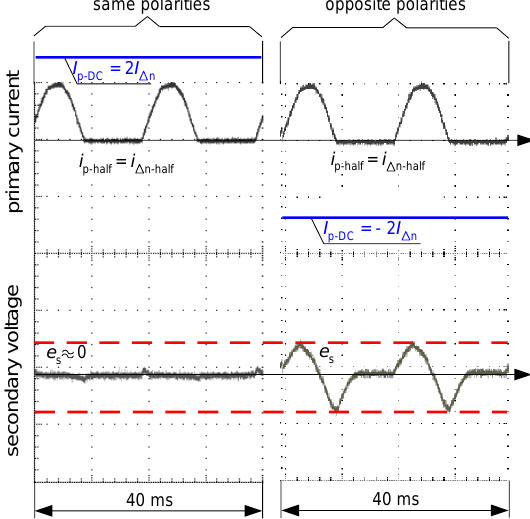
Figure 20. Oscillograms of the induced secondary voltage e s in case of the iron core of flat hysteresis loop (as in Figure 15b). Primary current i p composed of pulsating DC (half-wave) waveform ( i p-half = i ∆ n-half ) and DC component ( I p-DC ) of the value: I p-DC = 2 I ∆ n . Case 1 ( left ) — same polarities of the components; Case 2 ( right ) — opposite polarities of the components.